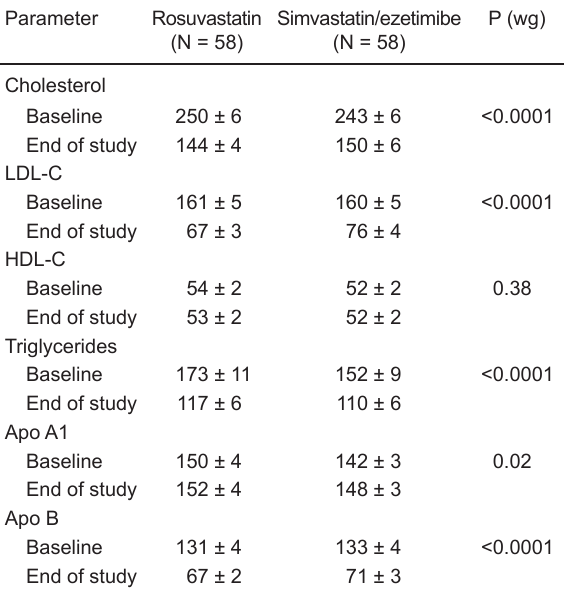
Table 2. Lipid and apolipoprotein parameters of the two groups at baseline and at the end of the study.